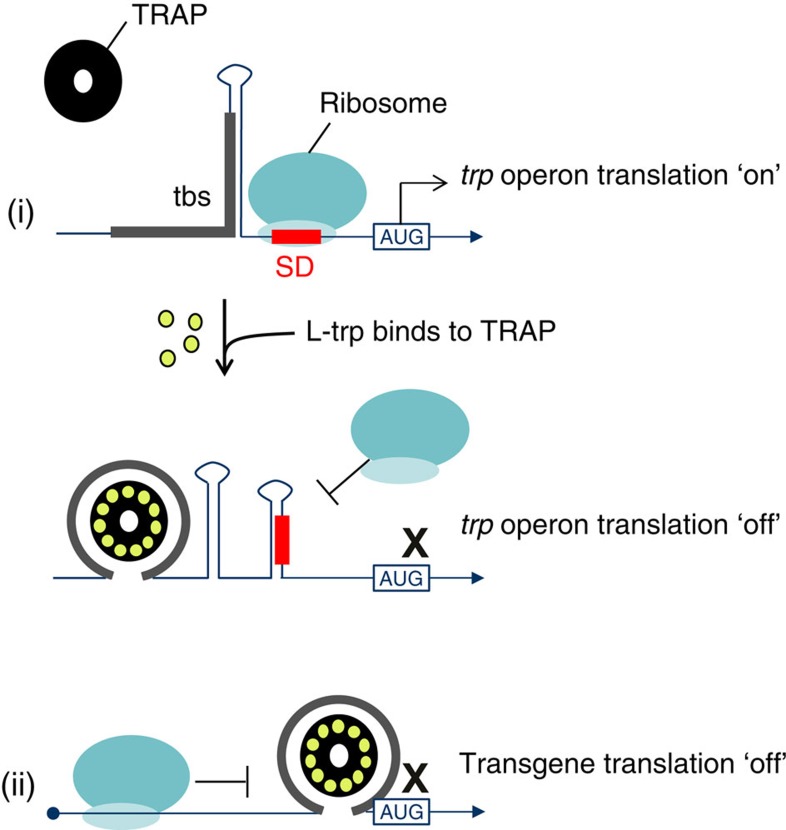
Overiew of translational block of the trp operon in B. subtilis by tryptophan RNA-binding attenuation protein (TRAP).(i) TRAP is an 8 kDa protein that associates into a homomeric, torroidal ring comprising 11 TRAP monomers. The trp operon RNA leader contains a TRAP binding sequence (tbs) of KAG repeats separated by two/three, or infrequently more than three spacing nucleotides that contribute to secondary structure within the leader; this results in exposure of the Shine–Dalgarno (SD) sequence and consequently efficient translation of the trp operon mRNA. When L-tryptophan is present in excess, each of the 11 TRAP monomers binds L -tryptophan resulting in a conformational change on the outside of the 11-mer ring such that it can bind tightly to the tbs. This re-orders the secondary structure within the leader, causing the SD to become unavailable leading to attenuation of translation initiation. (ii) The TRAP-tbs configuration used by Nie and Htun to exemplify a RNA-binding protein-identification screen20, and in this study for blocking of transgene translation in viral vector production cells.